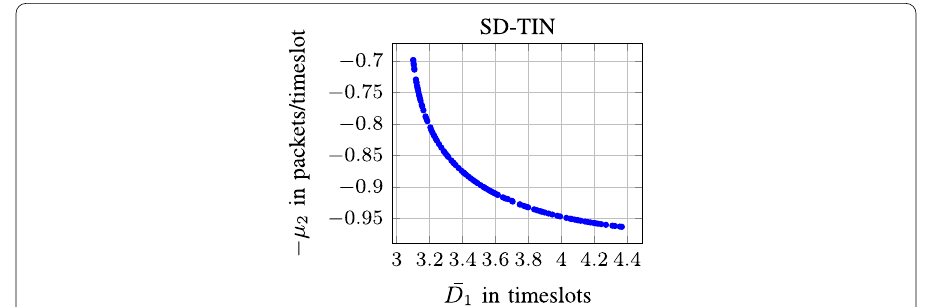
Fig. 10 Pareto set for (19) in SD-TIN. The rest of the parameters are the following: (cid:31) 1 = 0.1 , γ 1 = − 4.2dB , γ 2 = − 6.4dB , α = 2.2 , β = 41dB , P J = 23dB , B = 6 packets, P max = 23dB , d 2 = 14.6m , and d 12 = 10m . In SD-TIN, d 1 = 8.2m